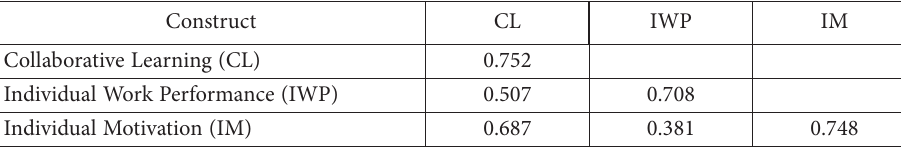
Table 6. Fornell–Larcker